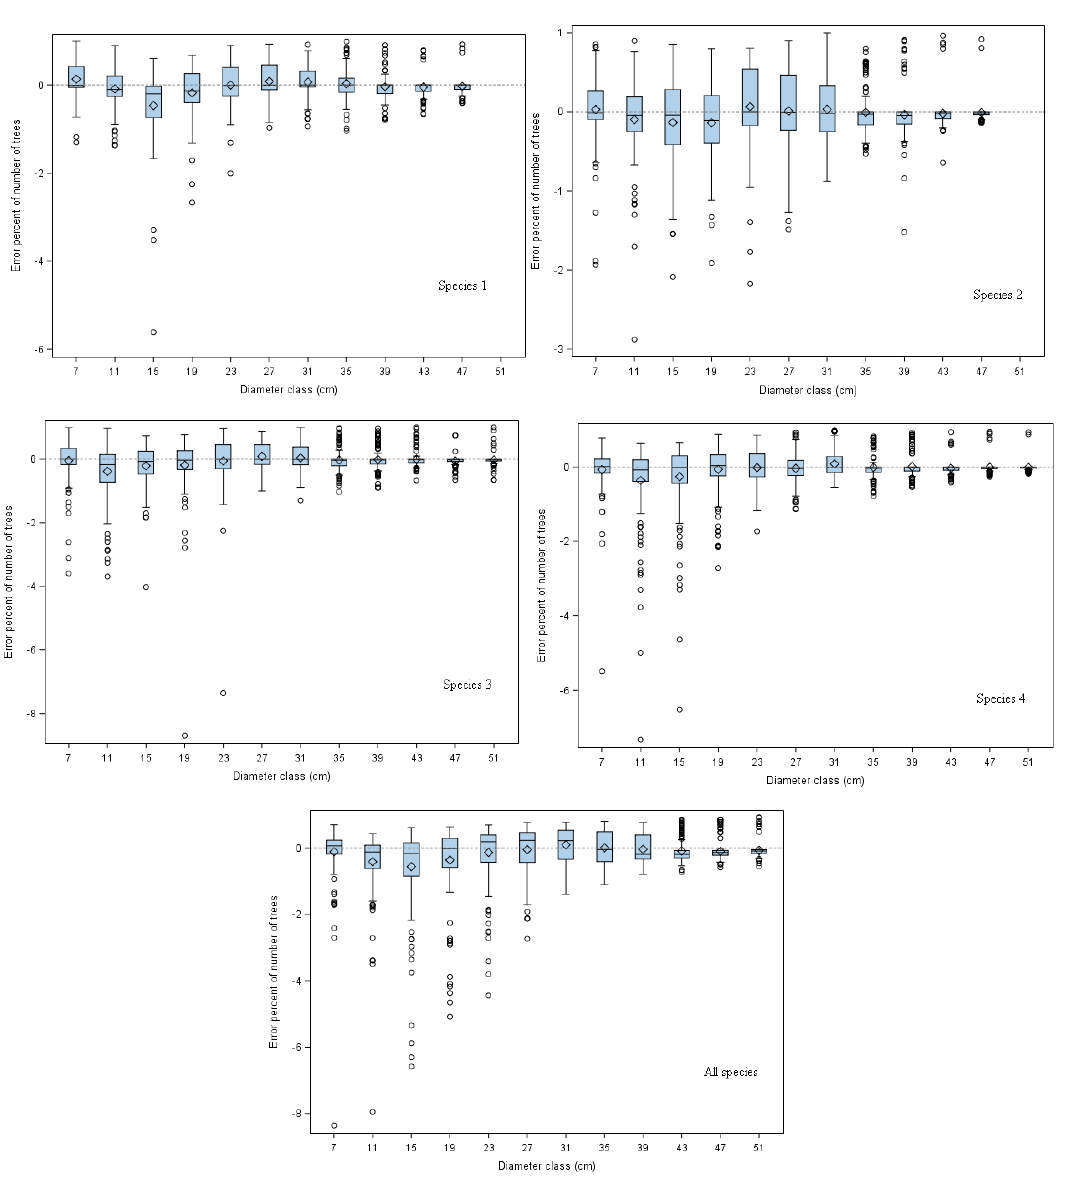
Figure 3. Error percent of the predicted number of trees against diameter class for each tree species group. The box plots display the whiskers, percentiles and mean of the predicted number of trees error percent for each diameter class, as well as outliers. Note the differences in scale on y-axis.